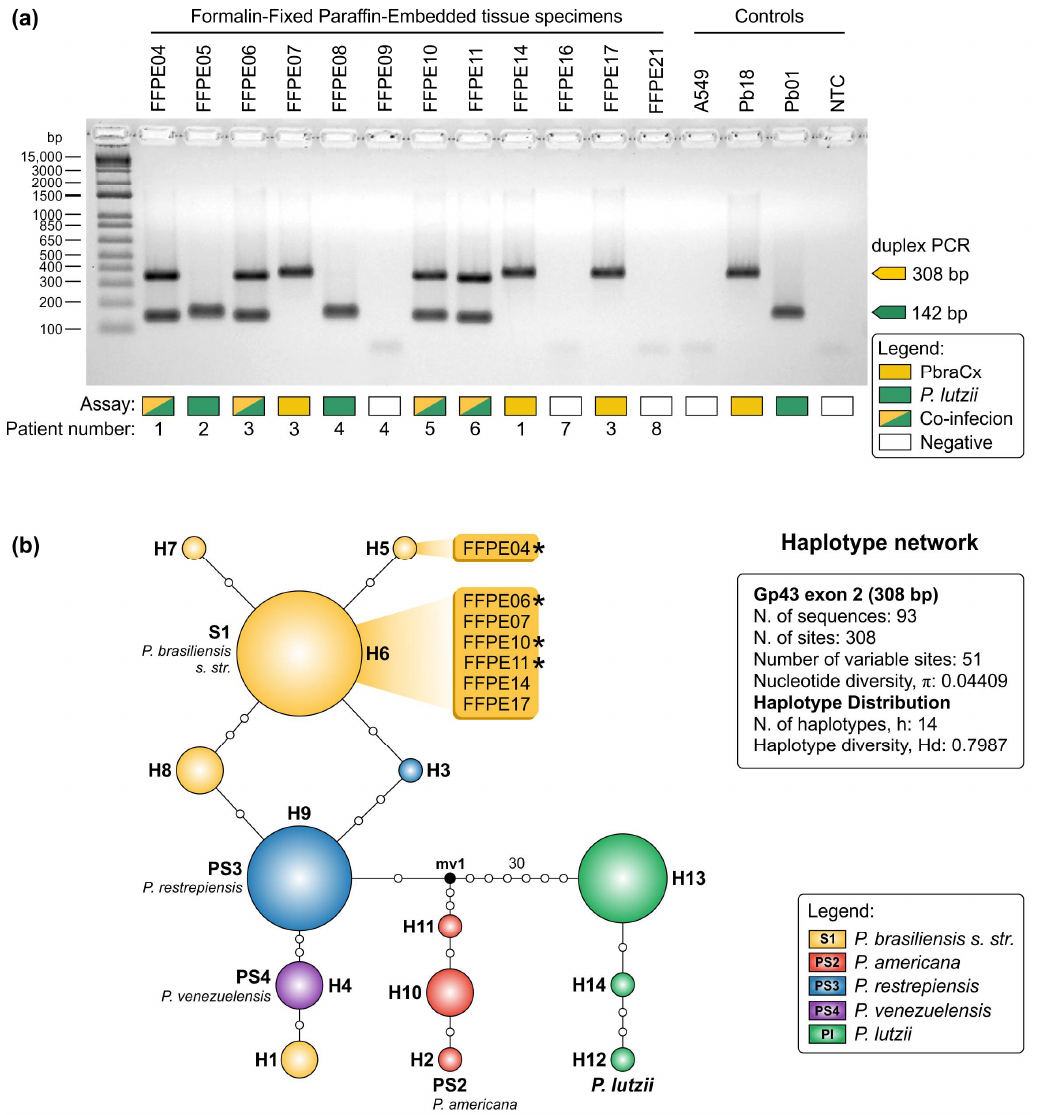
Figure 6. Detection of Paracoccidioides DNA from formalin-fixed, paraffin-embedded (FFPE) tissue sections. ( a ) Agarose gel electrophoresis showing successful detection of Paracoccidioides DNA using a duplex PCR assay. Remarkably, in four cases (i.e., FFPE04, FFPE06, FFPE10, and FFPE11), we confirmed co-infection due to P. brasiliensis s.l. and P. lutzii . Controls include DNA from A549 cells; Pb18: P. brasiliensis complex positive control; Pb01: P. lutzii positive control; NTC: no template control. ( b ) Median-joining haplotype network of Paracoccidioides species, covering all the 308-bp FFPE-derived sequences found in this study. The circumference diameter is proportional to the frequency of the haplotype. White dots represent mutational steps, and asterisks correspond to co-infections. Unsampled or extinct haplotypes in the population are indicated as black dots (median vectors). FFPE-derived sequences were clustered in two haplotypes (H5 or H6). Further information about sequence sources and GenBank accession numbers can be found in Supplementary Table S2.